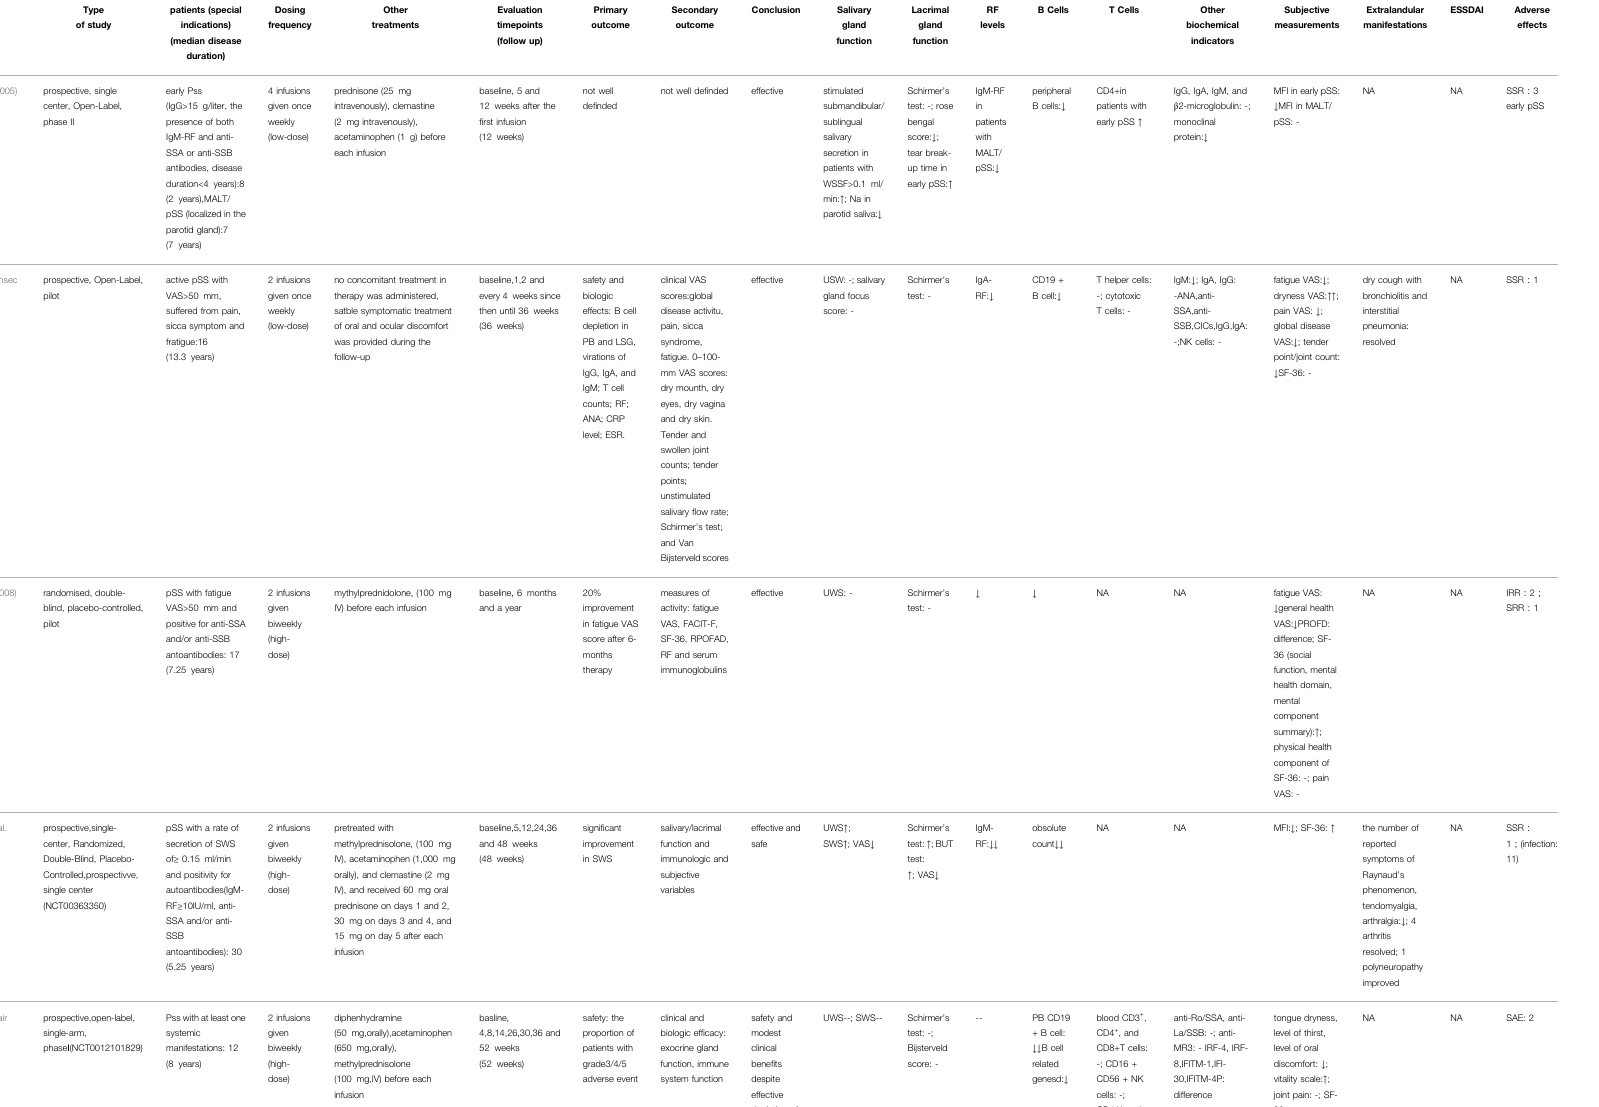
TABLE 1 | Main clinical trials evaluating the safety and ef fi cacy of rituximab treatment in pSS patients. Author